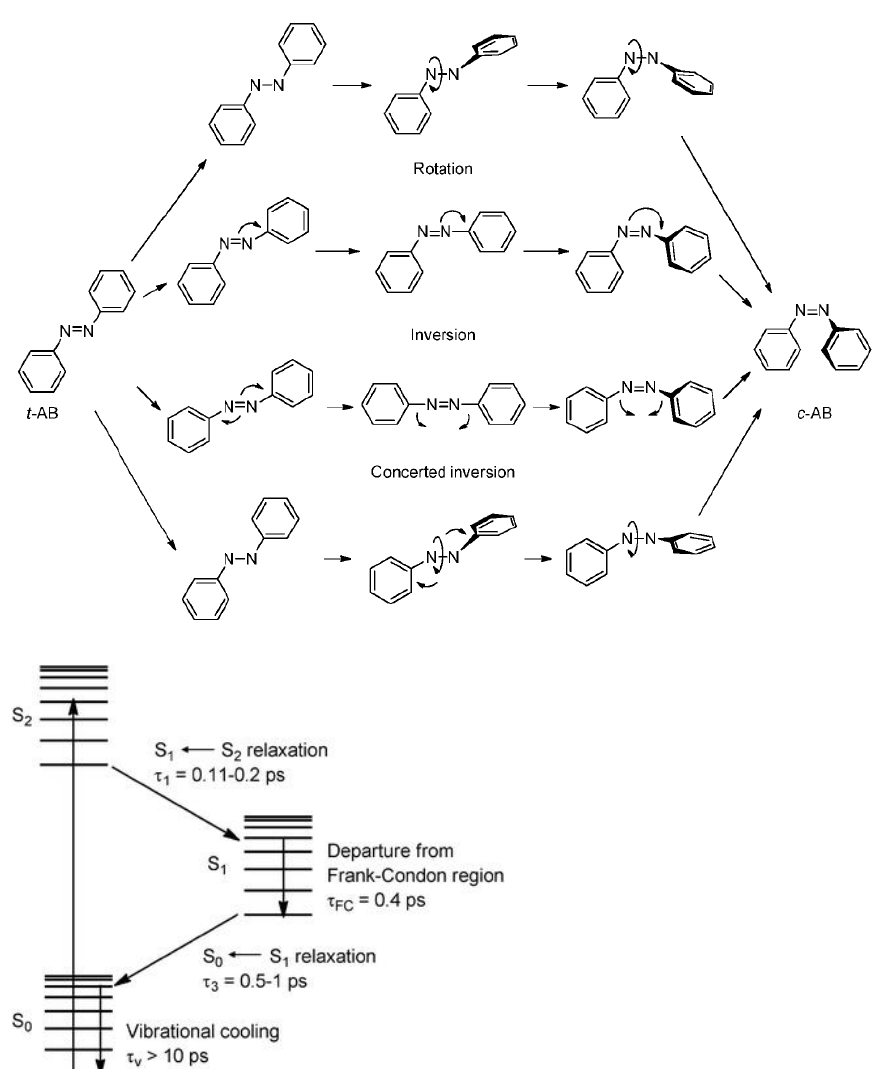
Figure 2. Proposed mechanisms for the trans-cis isomerization; A simplified Jablonski diagram showing the S0, S1 and S2. states of trans-azobenzene. Reuse (reprint) with permission of Bandara, H.M.D.; Burdette, S.C. Photoisomerization in Different Classes of Azobenzene. Chem. Soc. Rev. 2012